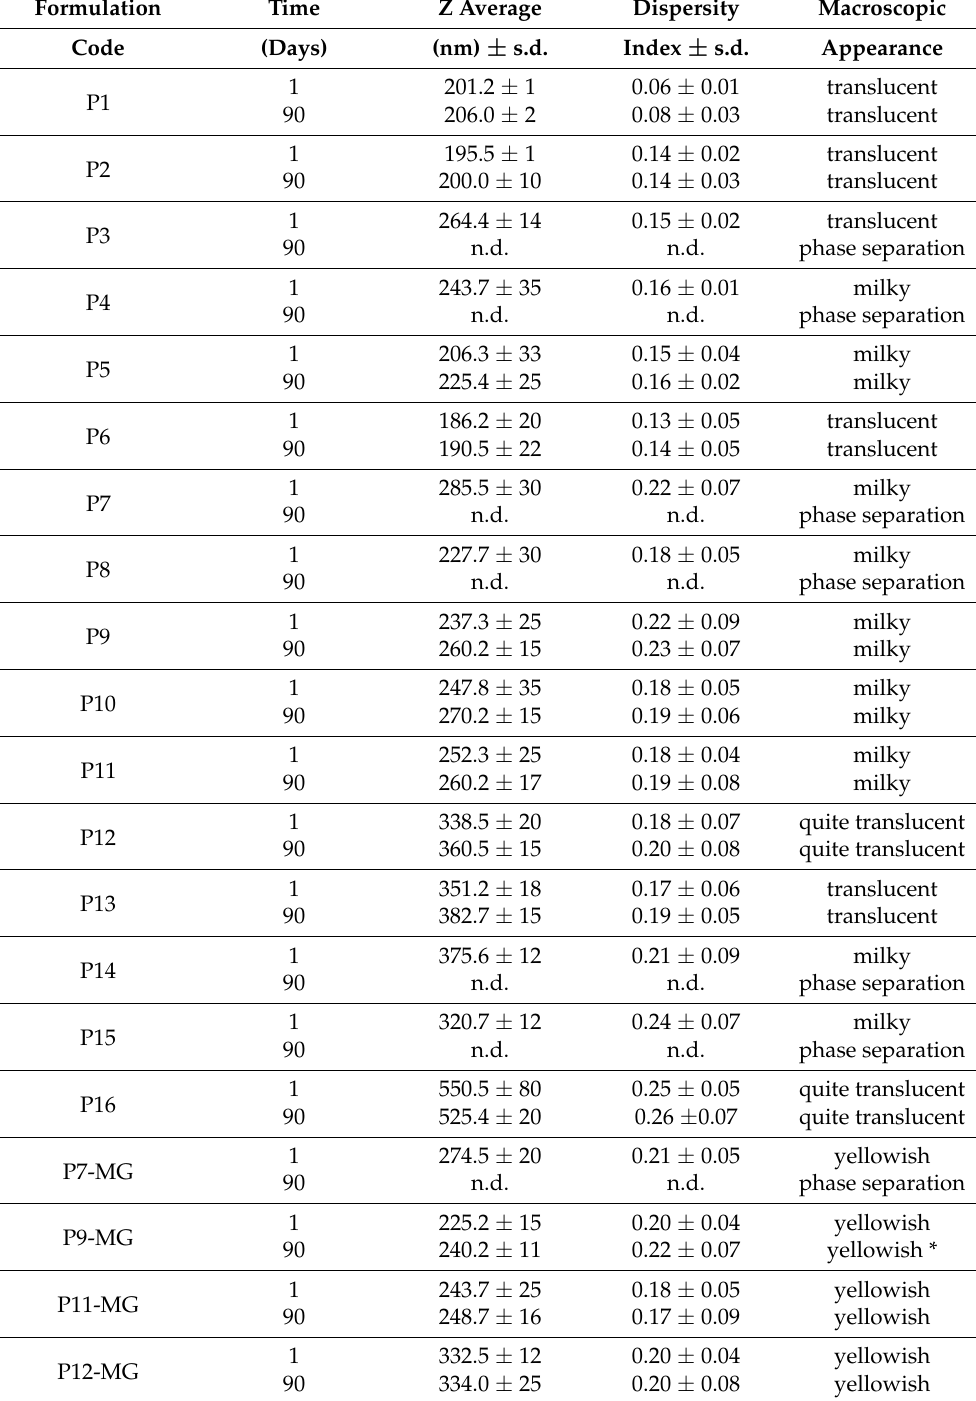
Table 2. Size distribution parameters of vesicular nanosystems, as determined by